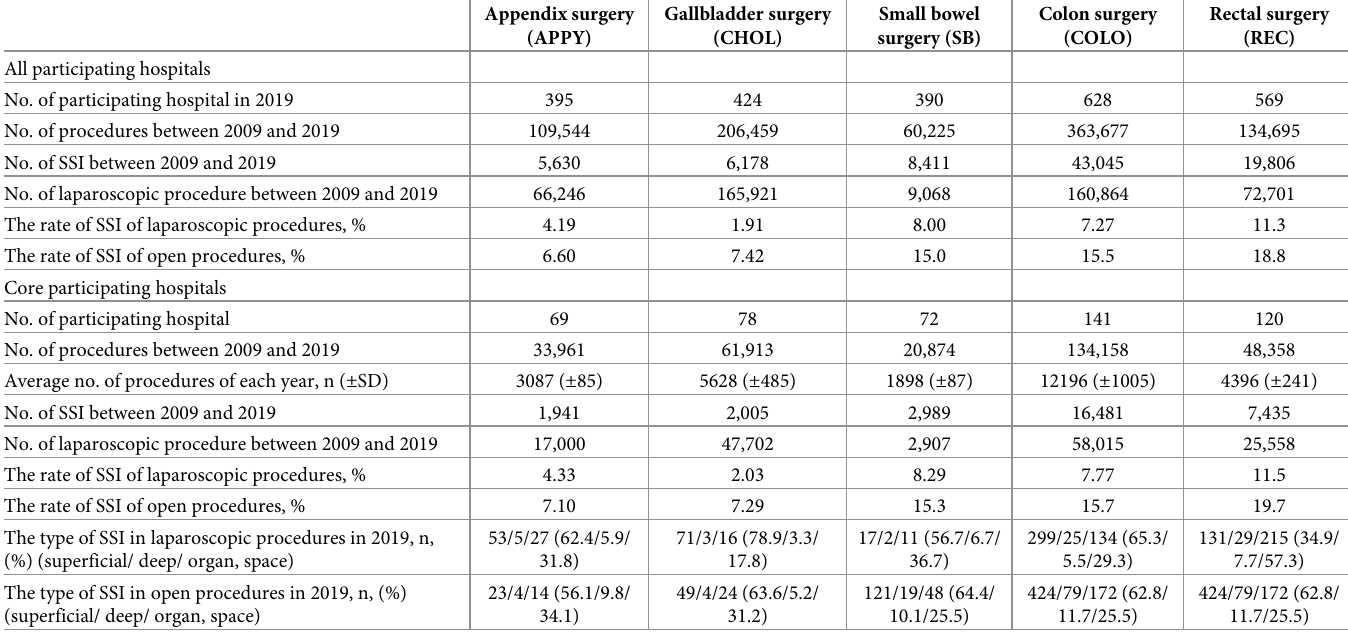
Table 1. Characteristics of five digestive